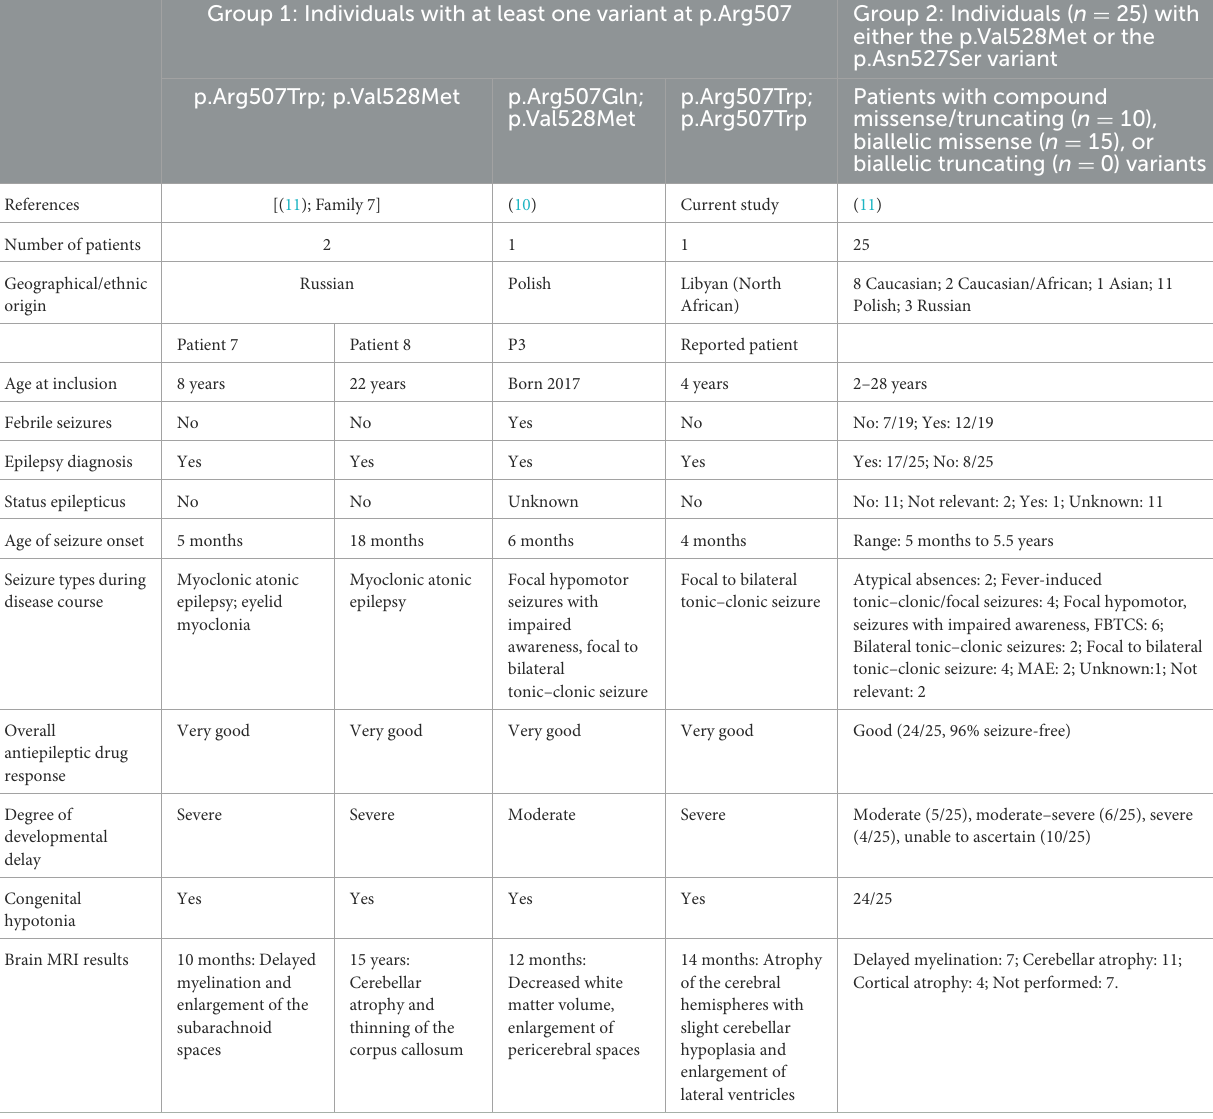
TABLE 1 Brief clinical overview of all individuals with PIGT deficiency associated with moderate seizure phenotype of variants within the C-terminal region ( PIGT : NM_015937.6) for whom clinical information has been published. Group 1: Individuals with at least one variant at p.Arg507 Group 2: Individuals ( n = 25) with either the p.Val528Met or